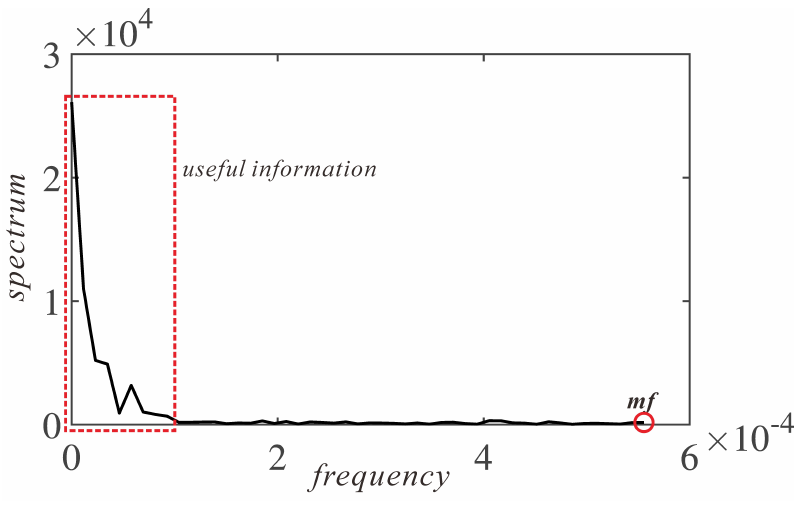
Figure 6. This is a figure, Schemes follow the same formatting. If there are multiple panels, they should Figure 6. The tra ffi c flow signals in the frequency domain after applying the FFT be listed as: ( a ) Description of what is contained in the first panel. ( b ) Description of what is contained